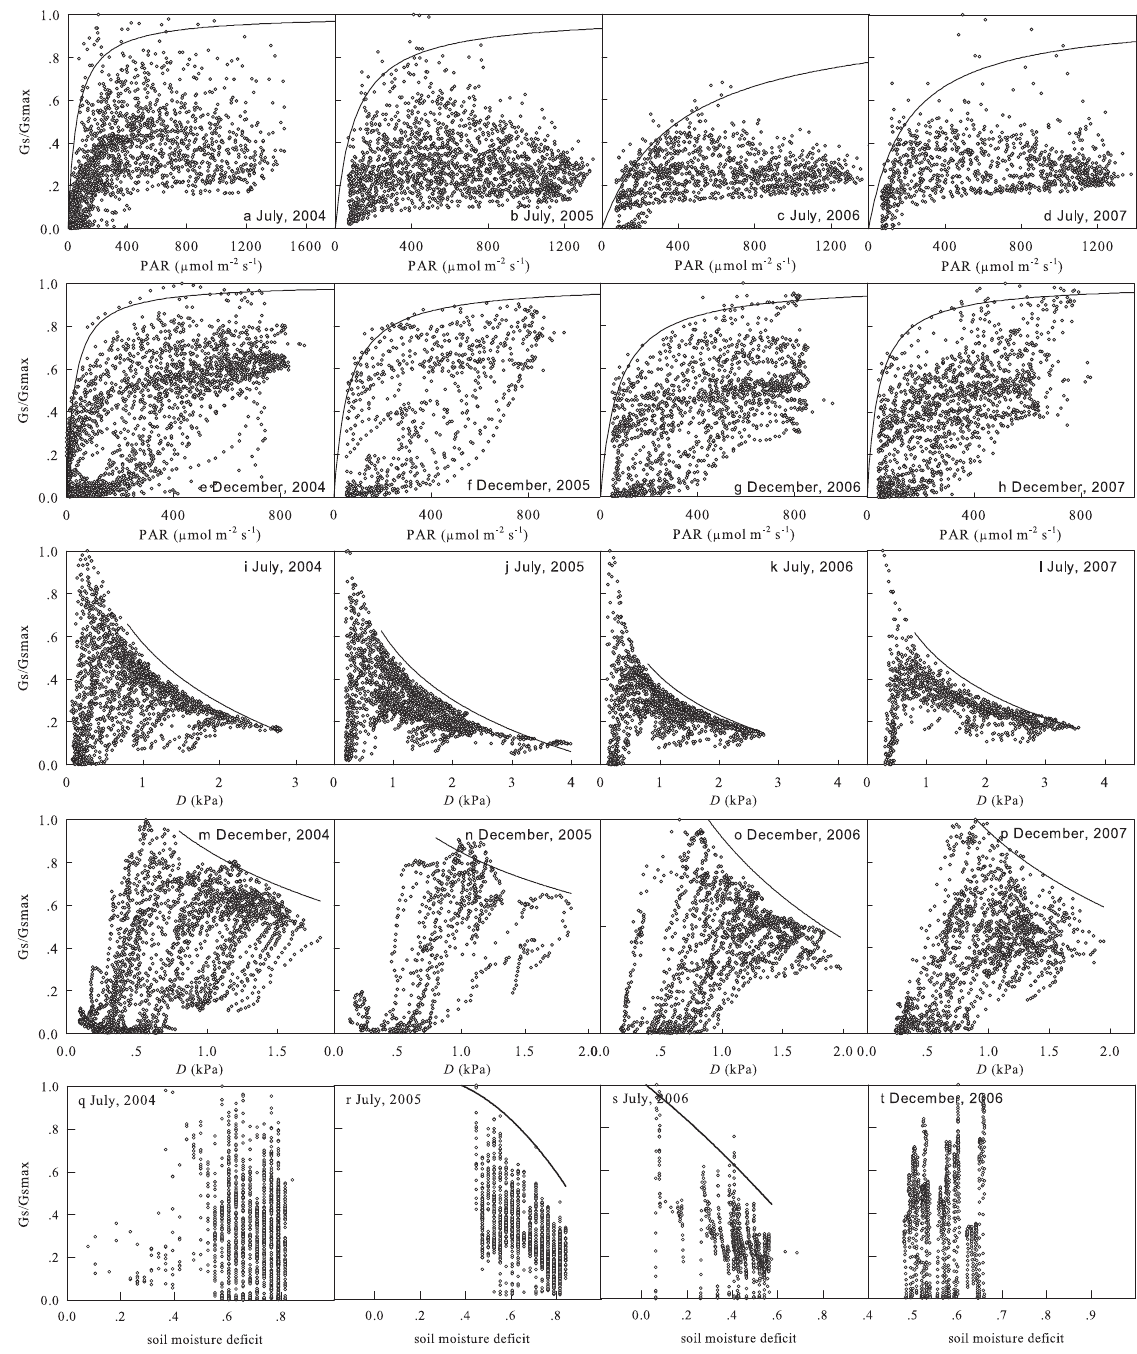
Fig. 3. Scatter plots and response functions of the ratio of canopy stomatal conductance to the maximum ( G s / G smax ) to changes in photo- synthetically active radiation (PAR) (a–h) , vapor pressure deficit ( D) (i–p) , and soil moisture deficit (SMD) (q–t) in both wet seasons and dry seasons from 2004–2007. Data were obtained through sap flow